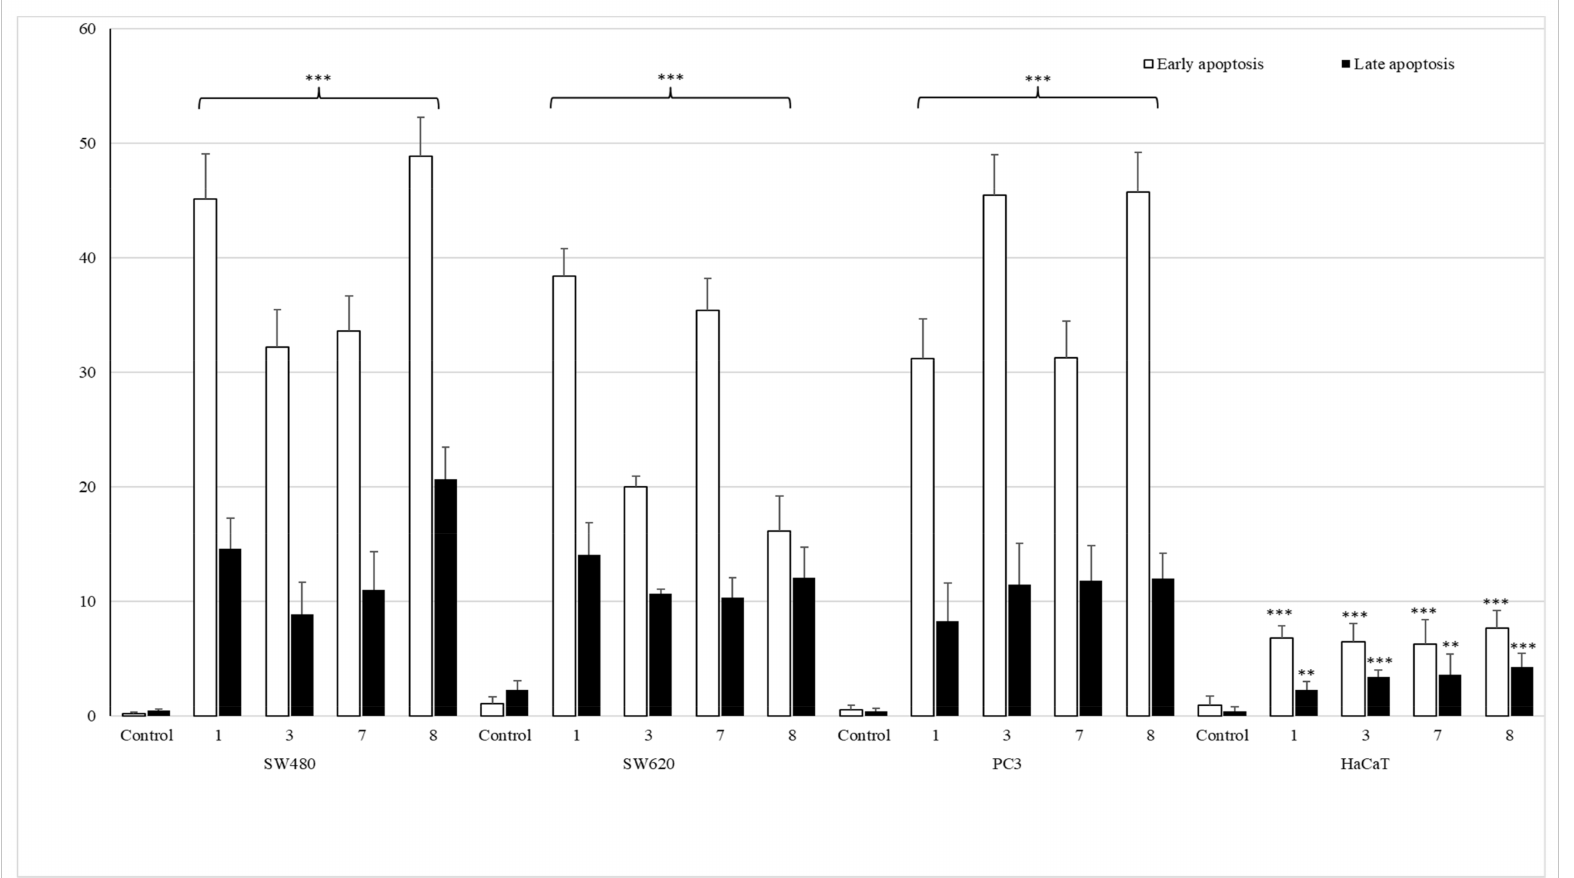
Figure 6. The effect of complexes 1 , 3 , 7 and 8 on early and late apoptosis, or necrosis in SW480, SW620, PC3 and HaCaT cells. Cells were incubated for 72 h with tested compounds used in their IC 50 concentrations. Then, cells were harvested, stained with annexin V-FITC and PI (fluorescein isothiocyanate and propidium iodide) and analyzed using flow cytometry. *** p ≤ 0.001, ** p ≤ 0.01 as compared to the